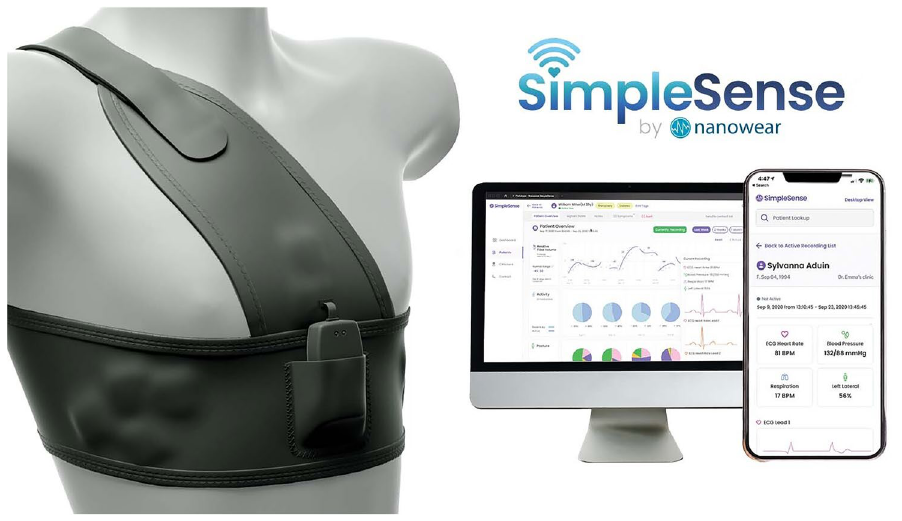
Figure 1. SimpleSense device and software